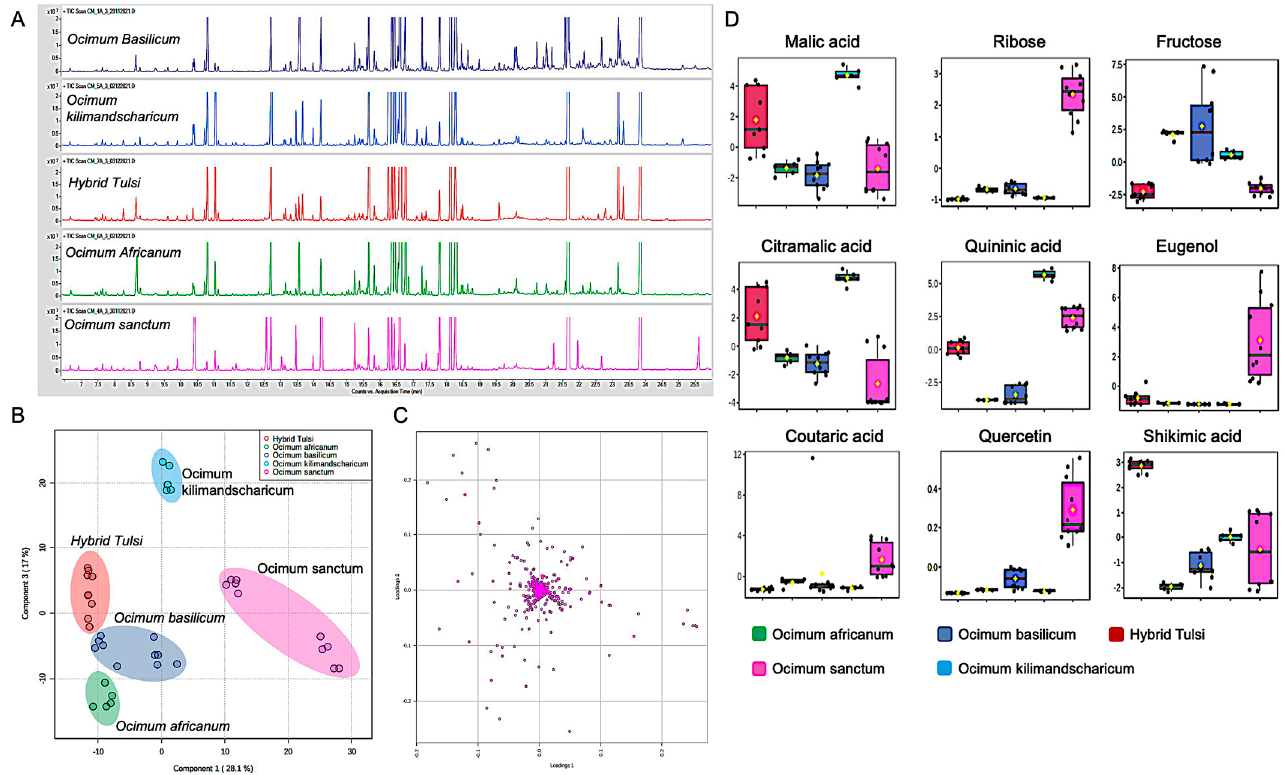
Figure 4. GC-MS-based metabolite fingerprinting identified species-specific differences in five different Ocimum species samples. ( A ) TIC of metabolite profile of five different Ocimum species. ( B ) PLS-DA scores plot for the first component (28.1%) vs. second component (17%), indicating differences between Ocimum species samples. ( C ) Corresponding loading plot for the metabolites. ( D ) Box plot for discriminatory marker metabolites, identifying the differences in five different Ocimum species. Normalised intensities are presented in the y -axis.